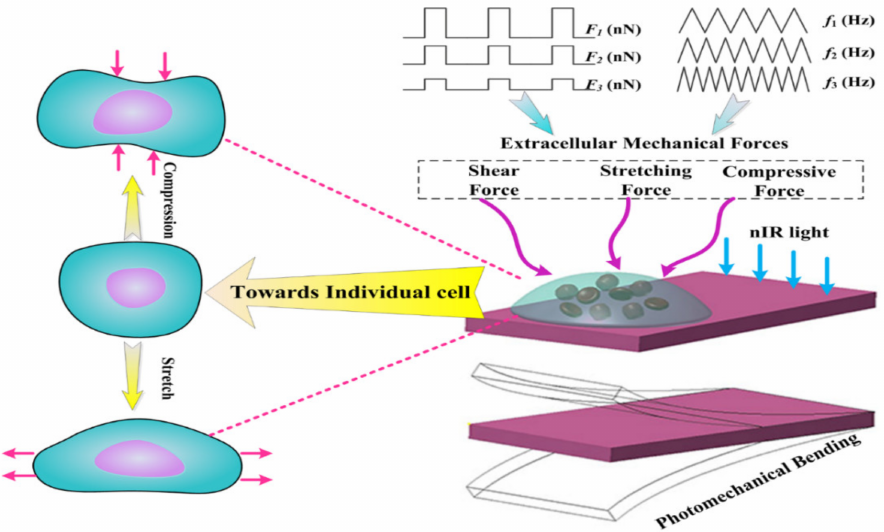
Figure 1. Design schemes for the mechanobiology platform realized by photomechanical soft